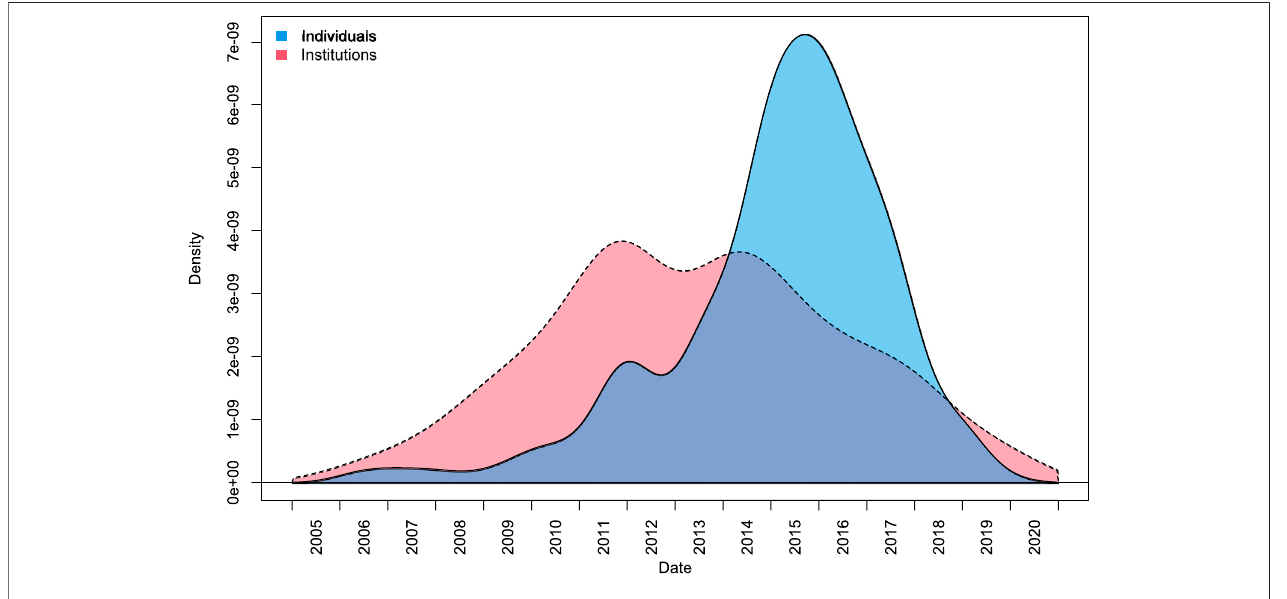
FIGURE 3 | Distribution of the date of creation of